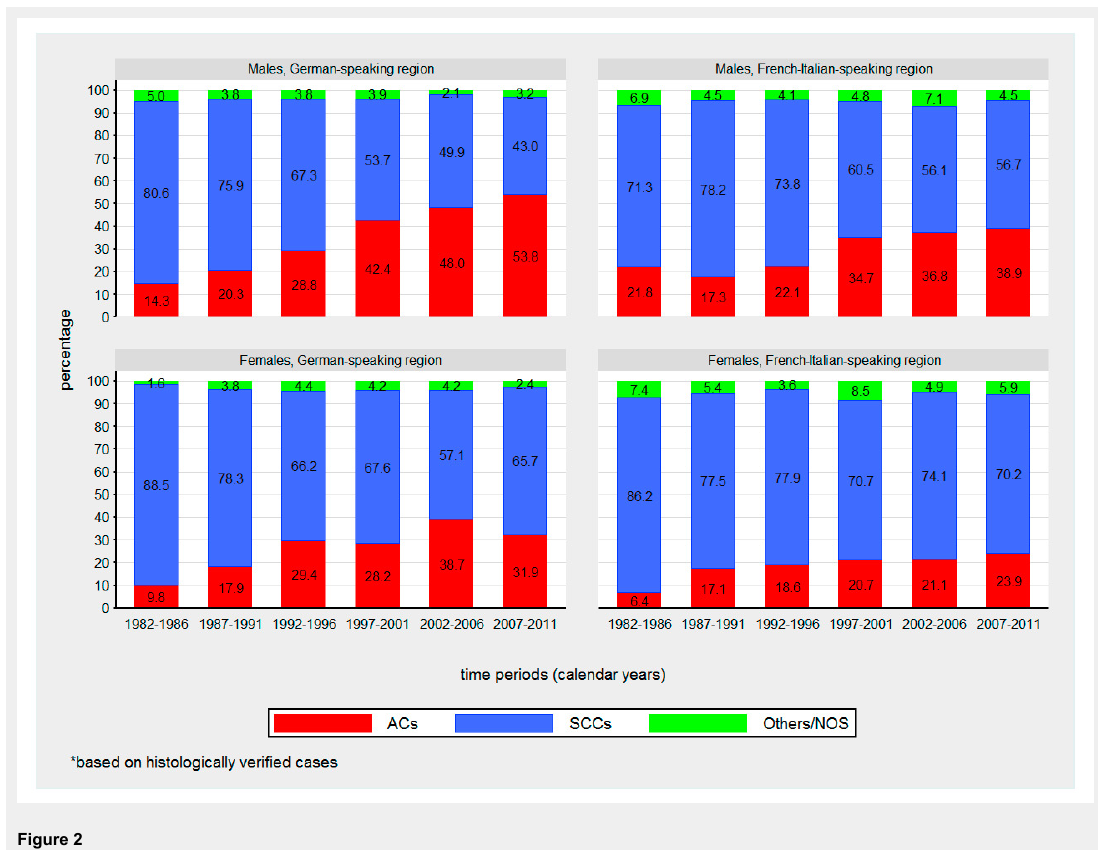
Figure 2 Time trends in proportions of oesophageal cancer cases by sex, histologic subtype and language region from 1982 to 2011. ACC = adenocarcinoma; SCC = squamous cell carcinoma, Others/NOS = other histologic subtype / not otherwise